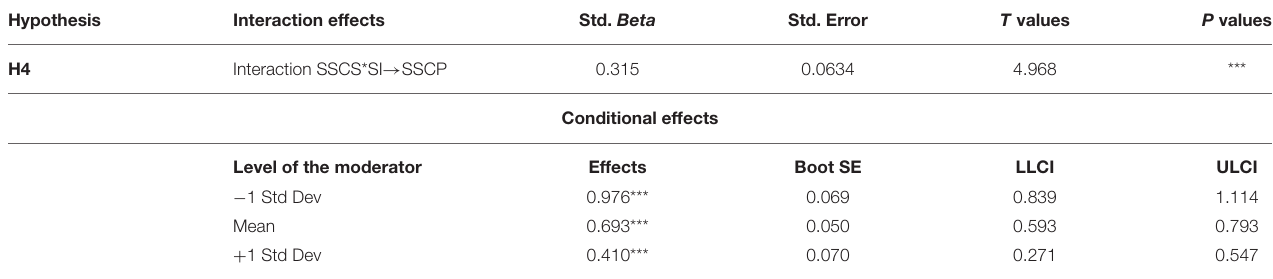
TABLE 5 | Interaction and conditional effects. Hypothesis